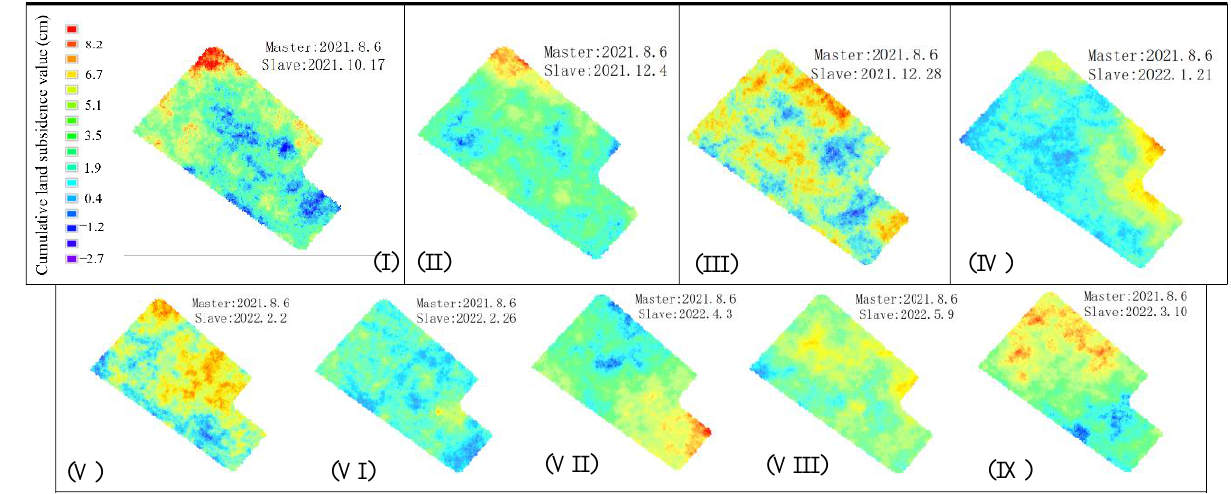
Figure 6. The amount of ground change (subsidence/cm) detected by D-InSAR continuously and periodically during the process of sea sand reclamation in the Mud receiving area. ( a – i ) plots cor- respond to different continuous time intervals.